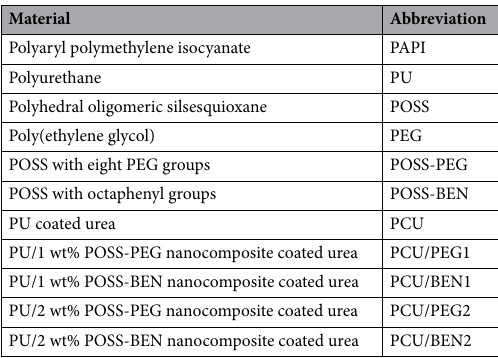
Table 3. Materials and corresponding